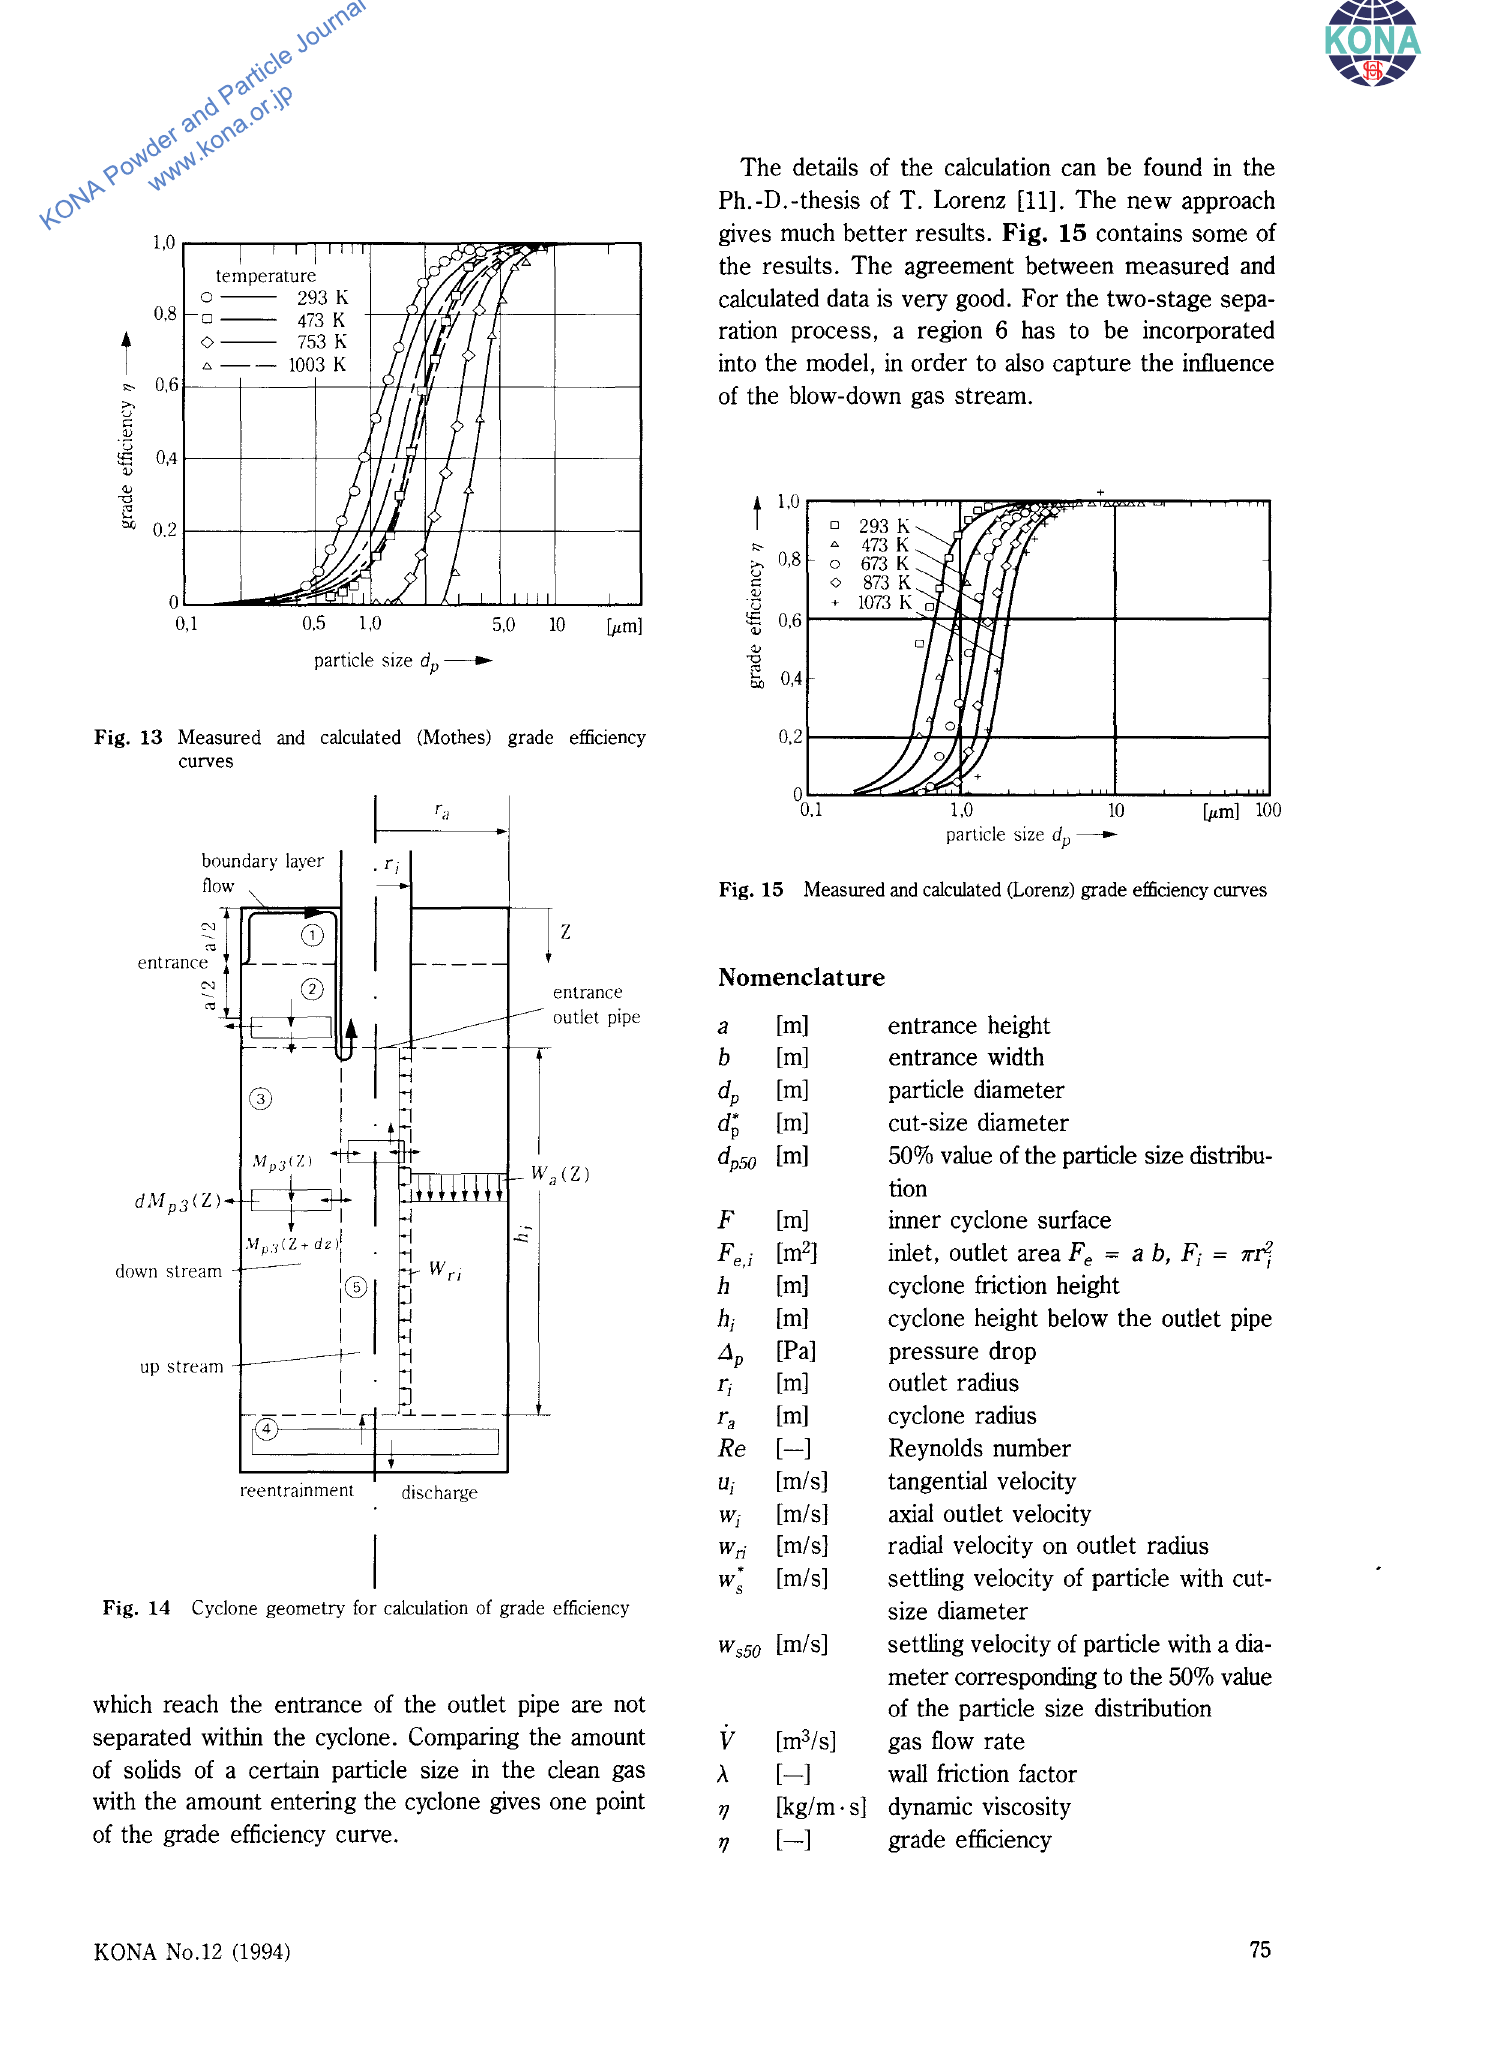
which reach the entrance of the outlet pipe are not separated within the cyclone. Comparing the amount of solids of a certain particle size in the clean gas with the amount entering the cyclone gives one point of the grade efficiency curve.